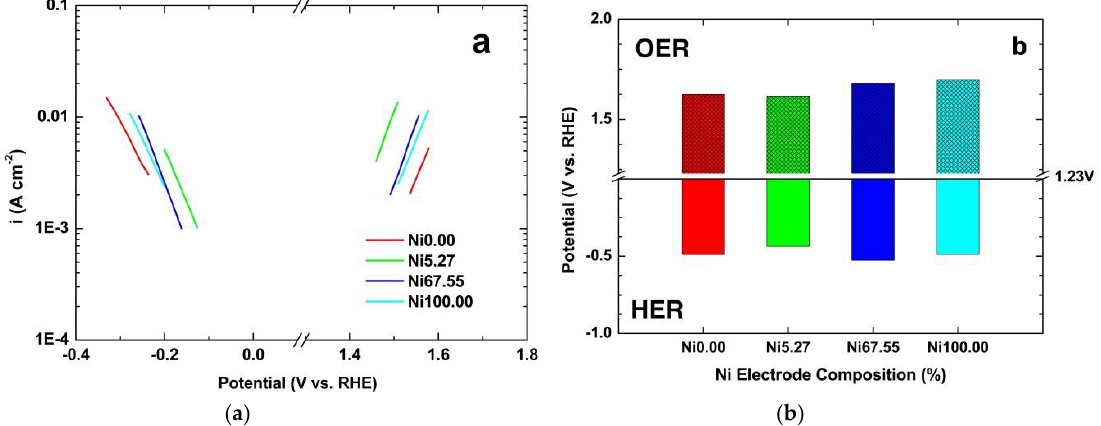
Figure 8. ( a ) QSSP and ( b ) mean value of cell potential of Ni-Co alloy nanowires with different composition obtained by electrodeposition in polycarbonate membranes.